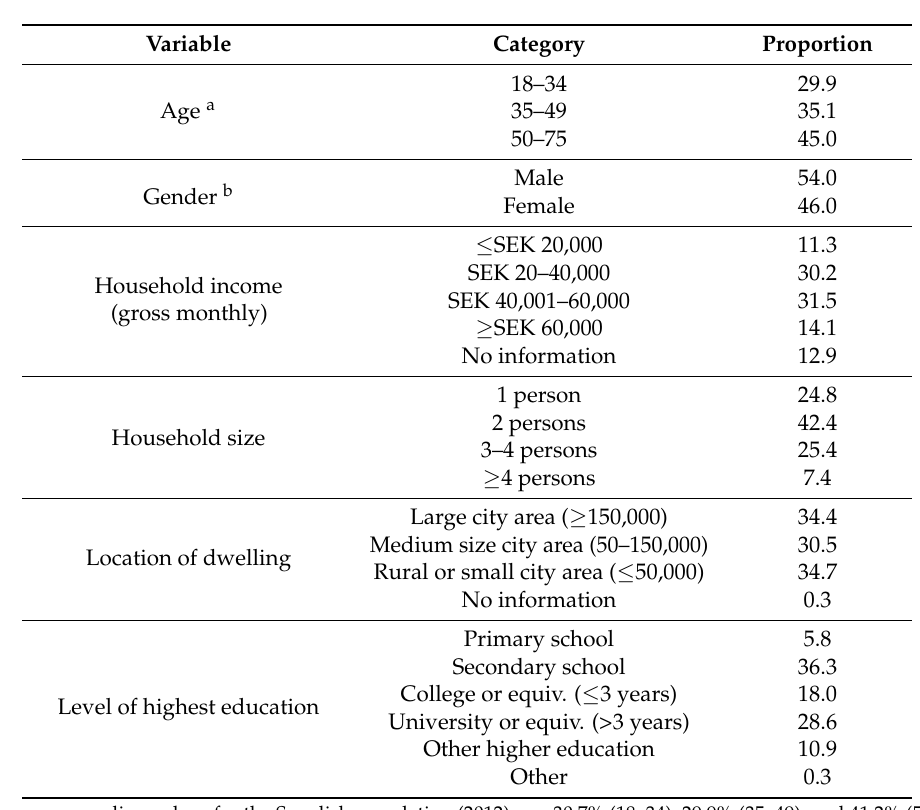
Table 1. Characteristics of the sample, % ( n = 336).